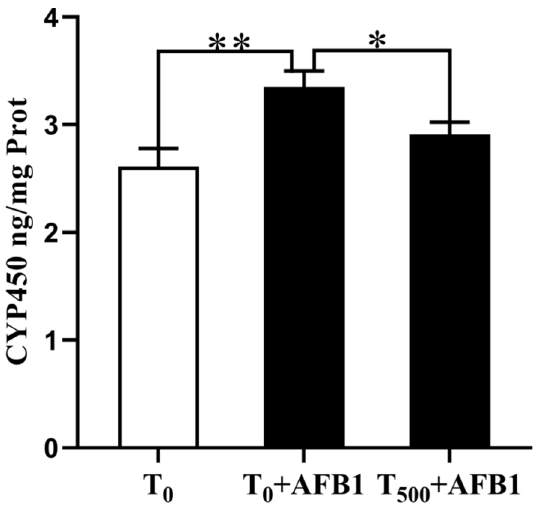
Figure 3. CYP450 level in liver of ducks exposed to AFB1 at 12 h. Values mean the mean ± SEM, * means p < 0.05, ** means p < 0.01.